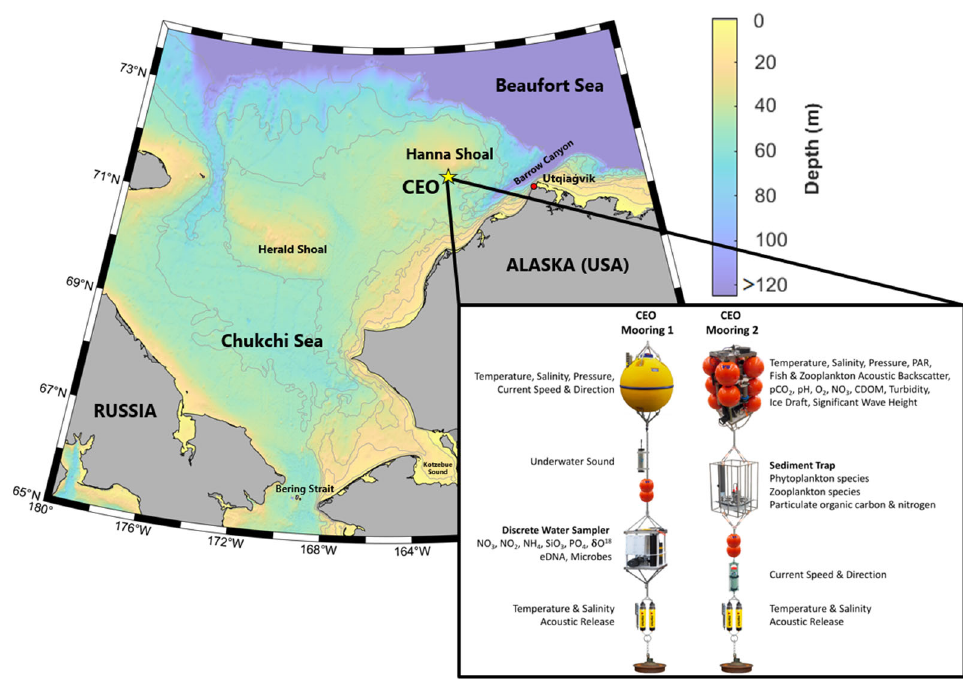
Figure 1. Map of the Chukchi Sea showing water depths. Bathymetric contours mark 100, 60, 50, 40, 30, 20, and 10 m depths. The CEO mooring site is marked with a yellow star, and the figure insert shows a diagram of the 2017–2018 CEO mooring configuration and measurement parameters. To measure acoustic backscatter, the Acoustic Zooplankton Fish Profiler (AZFP) instrument is located at the top of Mooring 2.